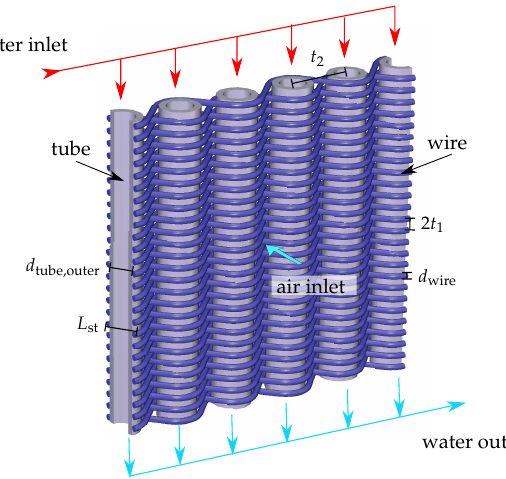
Figure 1. Schematic of a section of the wire cloth used in the air-to-water heat exchanger. Dimensions for the tested sample are given in Table 1.